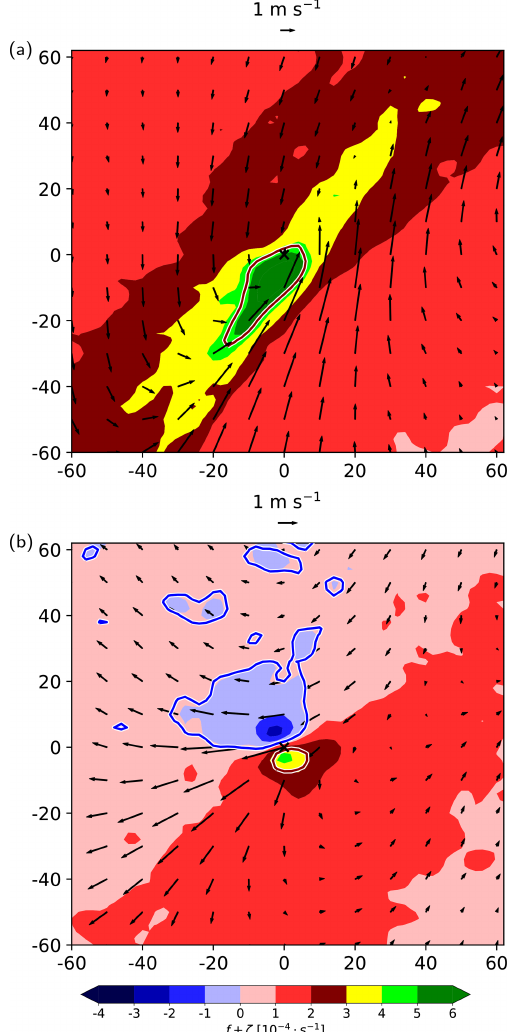
Figure 8. The same as Fig. 7a and c but for absolute vertical vor- ticity ( f + ζ , in s − 1 ) and 2h circulation anomalies (black arrows, in ms − 1 ) at (a) 800m and (b) 320K for convective WCB trajecto- ries 30min after the start of the fastest 400hPa ascent. The 0 and 2PVU contour lines are shown in blue and red,